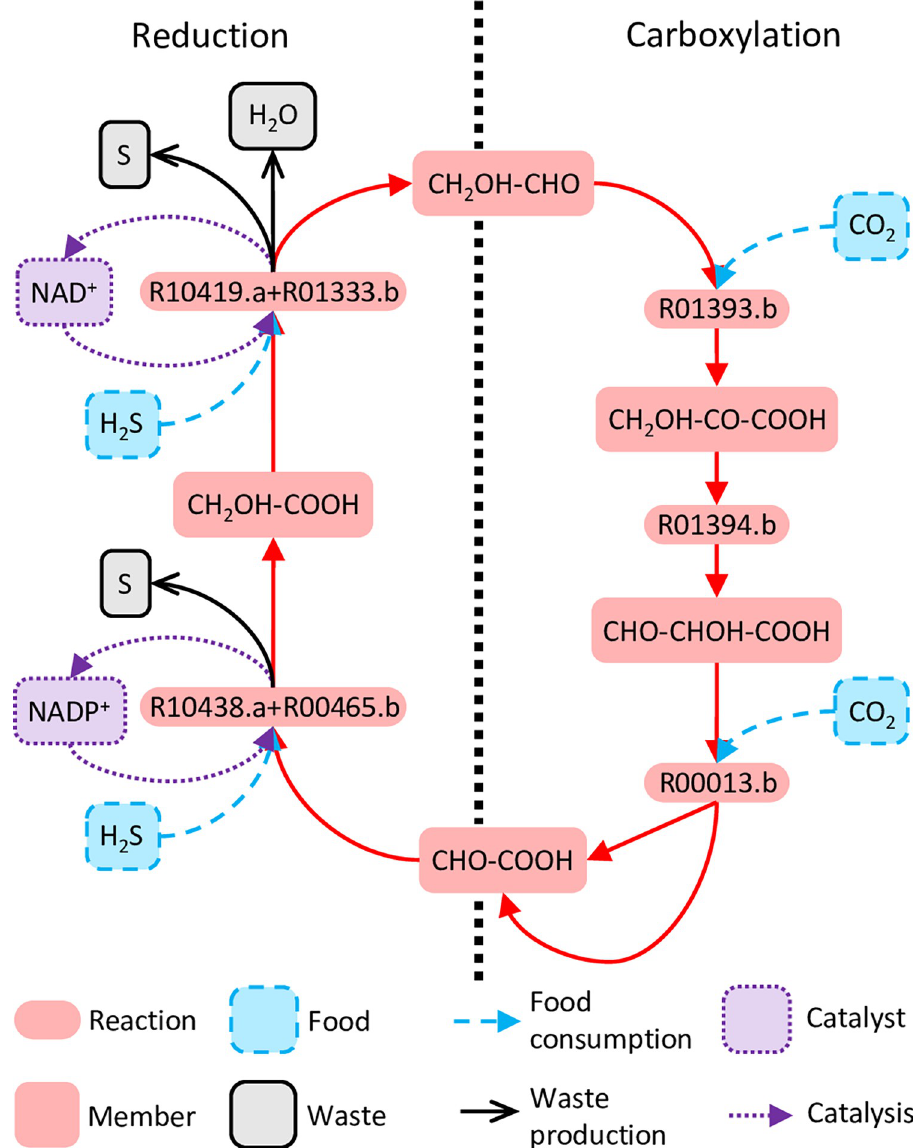
2 S into possible terminal hydrogen donors for reducing glyoxylic acid to glycolic acid and finally to glycolaldehyde, which creates a stoichiometrically autocatalytic cycle that performs carbon